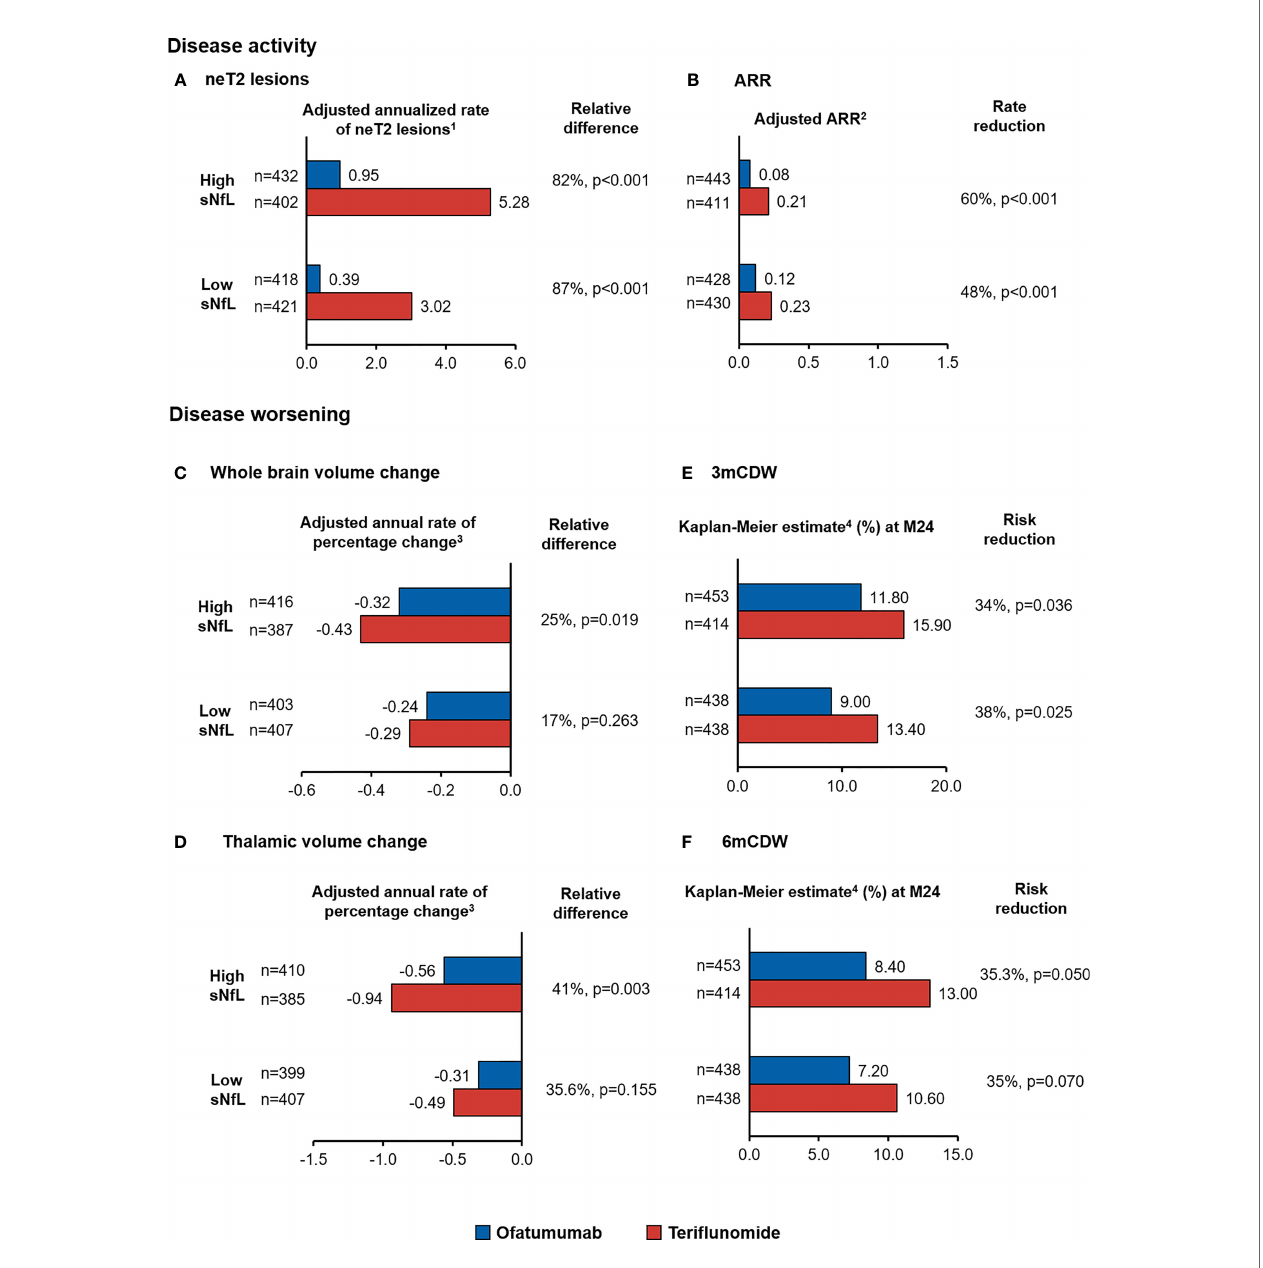
FIGURE 5 | Treatment effect of ofatumumab compared with teri fl unomide in the overall patient population, by baseline sNfL category, on measures of MS disease activity, namely, (A) neT2 lesions and (B) ARR, and disease worsening, namely, (C) whole brain volume change and (D) thalamic volume change time to (E) 3mCDW and (F) 6mCDW. 1 Adjusted annualized mean rate of neT2 lesions. The number of neT2 lesions (compared to baseline or month 12) was analyzed in a negative binomial model with adjustments for treatment, baseline sNfL category, region and study as factors, and age, baseline volume of T2 lesions as continuous covariates, and treatment by baseline sNfL category interaction. The natural log of the time from the baseline scan (in years) was used as the offset. 2 The ARR was analyzed in a negative binomial regression model with log-link to the number of relapses adjusted for treatment, baseline sNfL category, region and study as factors, number of relapses in previous year, baseline EDSS, baseline number of Gd+T1 lesions, and the patient ’ s age at baseline as covariates and treatment by baseline sNfL category interaction. The natural log of the time in study was used as offset to annualize the relapse rate. 3 Adjusted annual rate of brain volume change as estimated in from the random coef fi cient model with study fi t to the post-baseline assessments measured at M12, M24, and end-of-study, treatment as fi xed effects (factors), and time as continuous covariates and treatment by time interaction for the overall analysis, with additional co-factors of subgroup, treatment by subgroup, and treatment by time by subgroup interactions for the subgroup analysis. Random terms for slopes and intercept are included. 4 Cox regression adjusted study as stratum, treatment, region, and sNfL baseline high – low subgroup as factors and baseline EDSS as a continuous covariate along with treatment-by-sNfL baseline high-low subgroup interaction. ARR, annualized relapse rate; BVL, brain volume loss; 3mCDW, 3-month con fi rmed disability worsening; MRI, magnetic resonance imaging; neT2, new or enlarging T2 lesions; n.s., non-signi fi cant; sNfL, serum neuro fi lament light